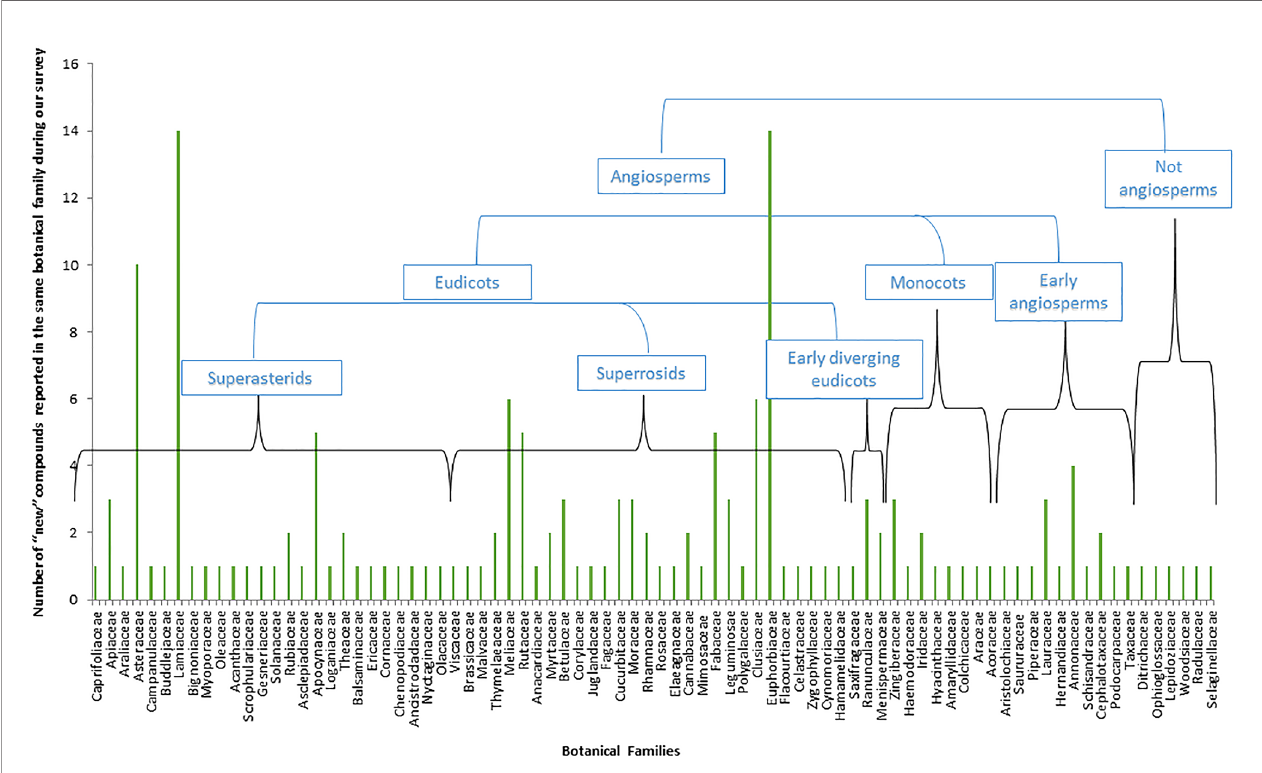
FIGURE 2 | Representation of the relative weight of the different phylogenetic groups in the number of “ new ” compounds reported based on our survey ( Table 4